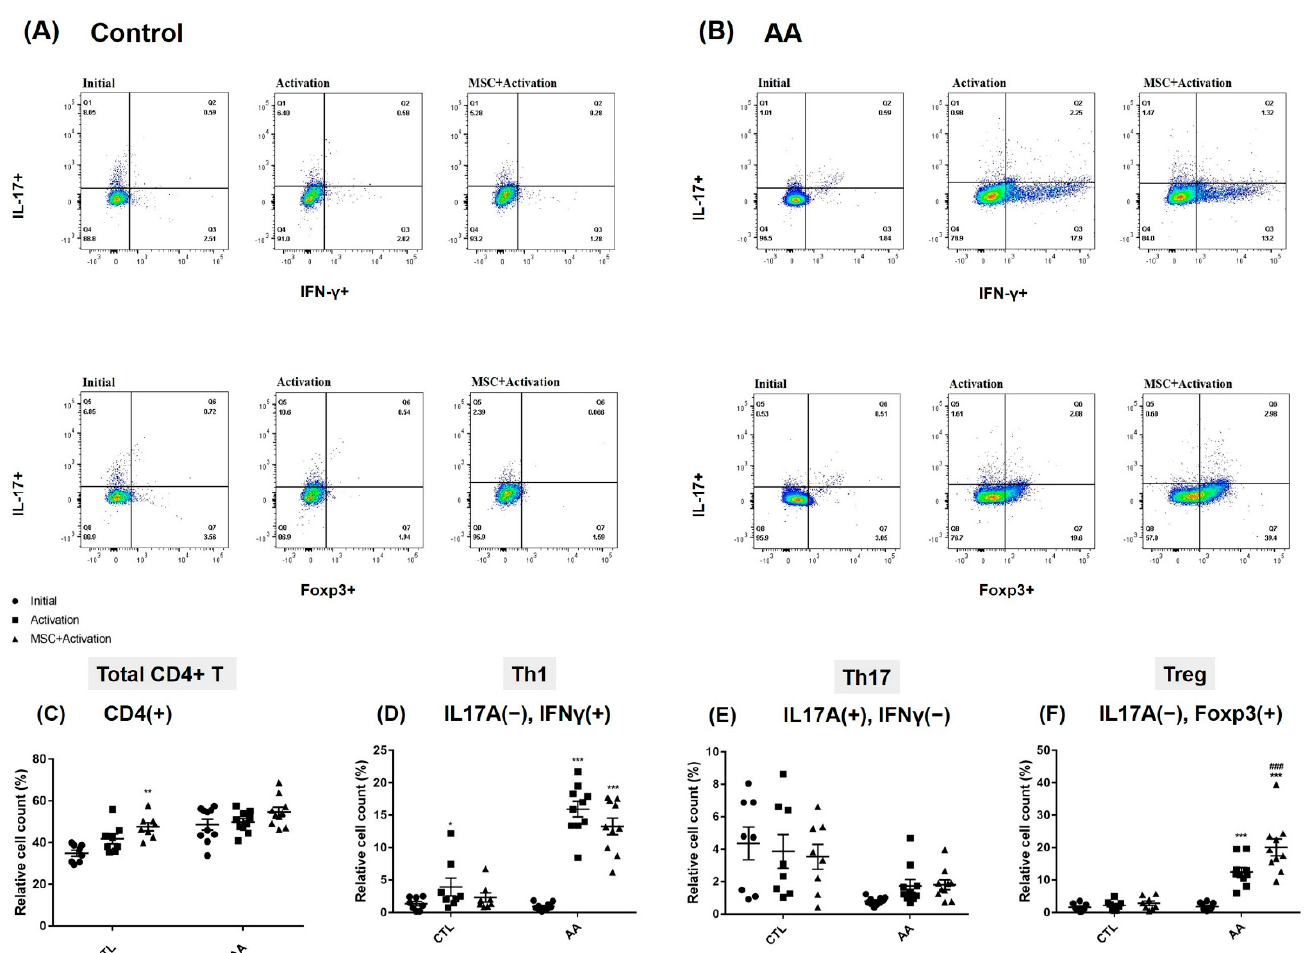
Figure 3. Representative FACS analysis results of IL-17+/ − IFN- γ +/ − cells and IL-17+/ − Foxp3+/ − cells at baseline, after activation, and after co-culturing with hMSCs in activation in ( A ) healthy control and ( B ) AA. The effects of hMSC treatment on ( C ) total CD4+Th, ( D ) Th1, ( E ) Th17, and ( F ) Treg cell subsets in PBMCs were examined. When stimulated, the levels of Th1 and Treg cells of AA patients rose sharply compared to baseline, whereas the cells of healthy controls rose slightly. Co-culturing with hMSCs slightly decreased the activation levels of Th1 cells compared to the activated control in AA patients. Meanwhile, Treg cells were markedly induced by allogenic hMSC treatments in AA patients compared to the activated control, although these changes were not prominent in health controls. The Th17 cell ratio was less affected by stimulation in both patients and controls. Single cell suspensions were prepared from healthy controls (CTL; n = 8) and alopecia areata (AA; n = 10) patients. The data represent the means ± SEM. * p < 0.05, ** p < 0.01, and *** p < 0.001 compared to initial, ### p < 0.001 compared to the activation group.